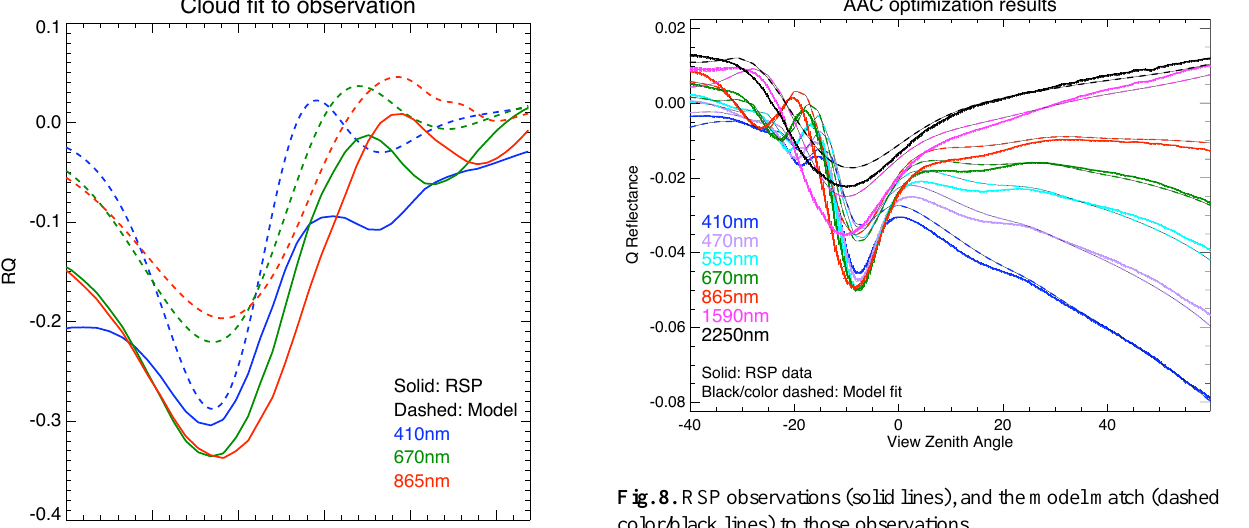
Fig. 8. RSP observations (solid lines), and the model match (dashed color/black lines) to those